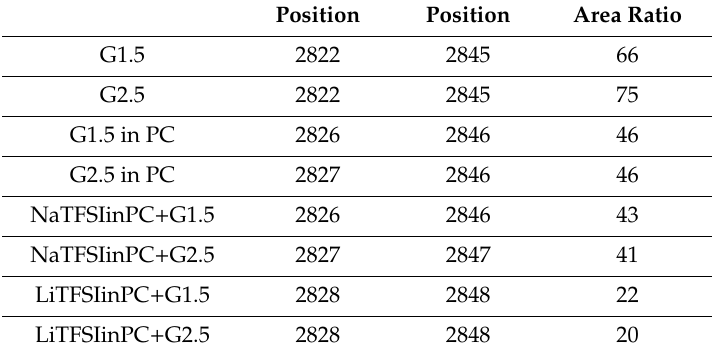
Table 4. Positions and area ratios of symmetrical CH 2 stretching bands of